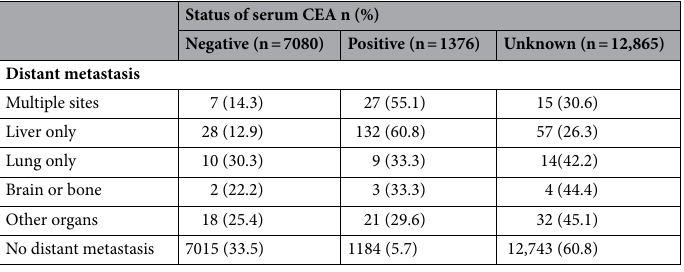
Table 4. Correlation between serum CEA and distant metastasis in patients with T1 colorectal